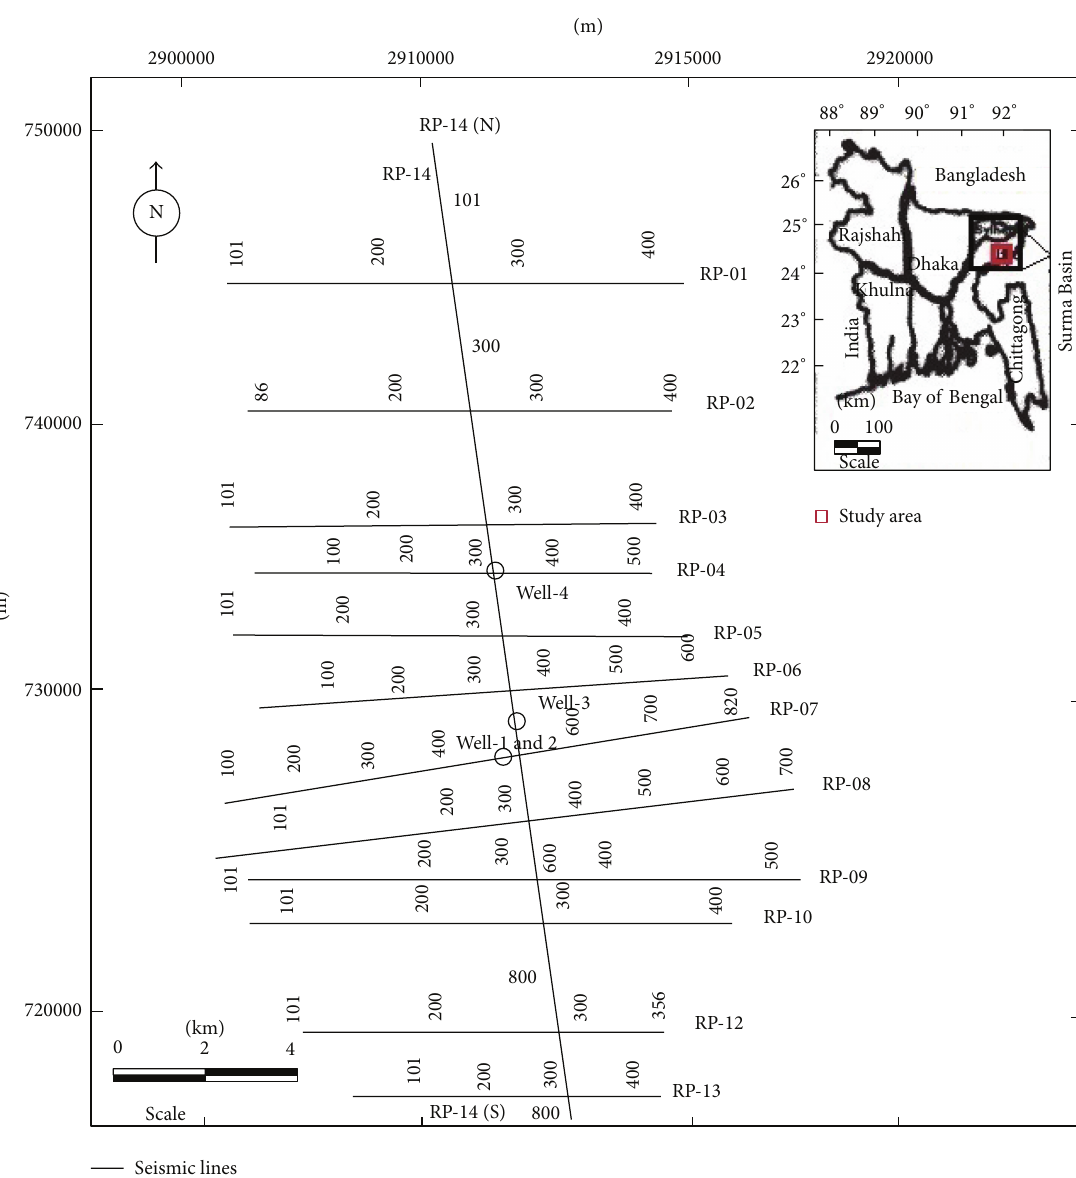
Figure 1: Location of the study and shot point map showing the orientation of 13 2D seismic lines (after modification from